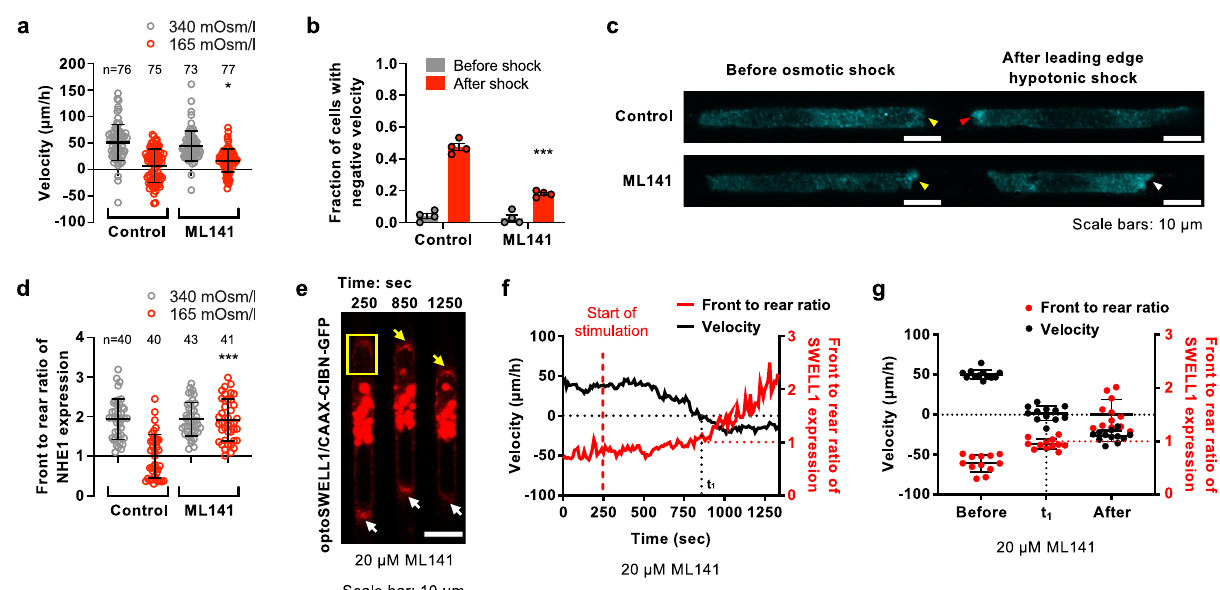
Fig.5|Cdc42facilitatesthereversalofmigrationdirectionbycontrollingNHE1 repolarization. a Migration velocity and b fraction of vehicle control and ML141- treatedMDA-MB-231cellsdisplayingnegativevelocitybefore(gray)and after(red) hypotonic shock (165mOsm/l) at the leading edge in con fi nement. Data represent the a mean±SD for the indicated number of cells or b mean±SEM from 3 ( a ) or 4 ( b ) independent experiments. c Representative images and d quanti fi cation of NHE1 polarization in vehicle control and ML141-treated MDA-MB-231 cells inside con fi ning channels before (340mOsm/l) and after (165mOsm/l) application of hypotonic shock at the leading edge. NHE1 is polarized at the cell leading edge in control and ML141-treated cells before osmotic shock (yellow arrowheads) and repolarizes to the “ new ” leading edge in response to osmoticshockonlyin control (redarrowhead),butnotML141-treated(whitearrowhead),cells.Datarepresentthe mean±SDfromthreeindependentexperiments. e Time-lapsemontageofanMDA-